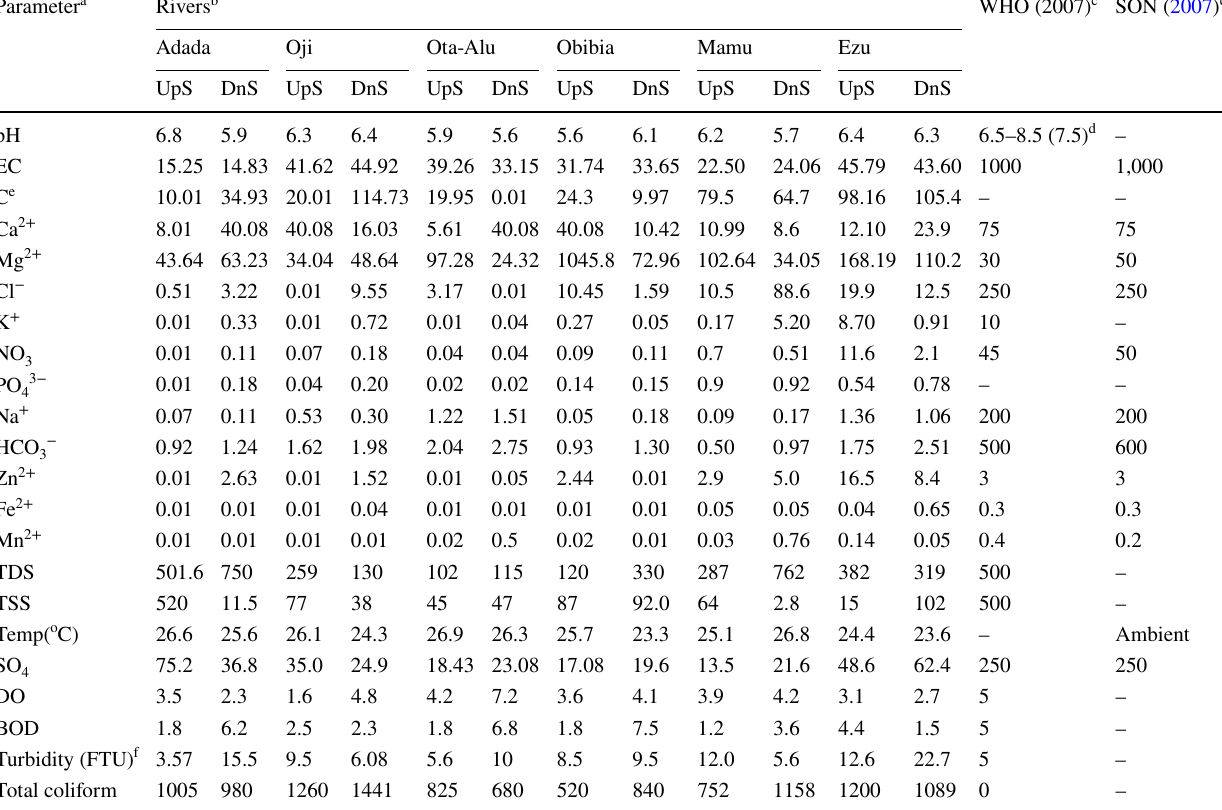
Table 5 Hydrochemistry of surface water from Mamu River basin in the rainy season